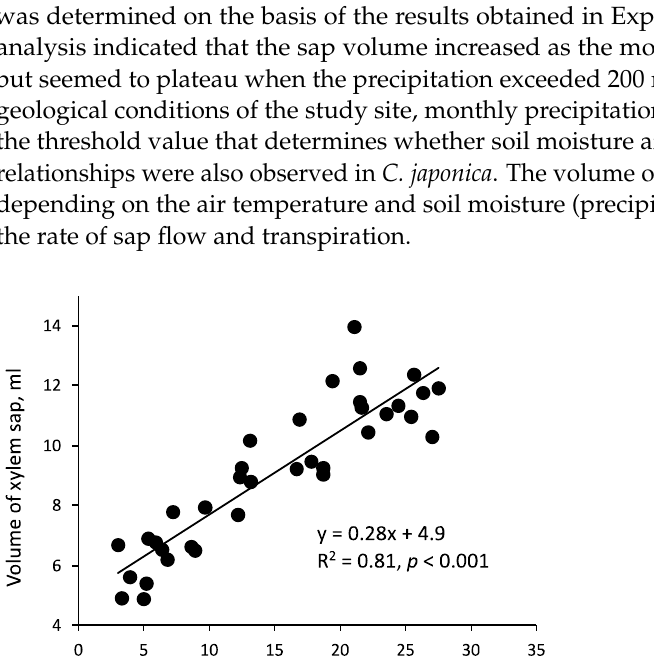
Figure 4. Relationship between the monthly volume of xylem sap collected in Q. serrata and the monthly precipitation. The presented data were from Experiments 1–3. The above results suggested that the volume of xylem sap collected was associated with the sap flow. Although the volume of sap collected was considerably smaller than that expected from the actual sap flow rates in trunks ( Q. serrata : 85–518 mL/cm 2 /d [82]; C. japonica : 27–69 mL/cm 2 /d [54]), probably because of the discontinuity of sap flow in the sampling holes [83], the changes in the volume of sap collected appeared to have syn- chronized with those in the sap flow rates. Additionally, even when only a few conduits or tracheids were disconnected, the sap flow system remained functional because xylem sap can flow upward by bypassing damaged areas [84]. Xylem sap can flow slowly in a radial direction through the pits of conduits or tracheids and/or the xylem ray paren- chyma [85–91]. Therefore, the xylem sap collected was considered as the exudate from the healthy sap flow system. Moreover, the original solute concentrations and composi- tions may have been maintained. The acid fuchsin dye, which was injected into the xylem as a 0.1% solution (1000 mL) at ca. 50 cm below the sampling hole, was detected in the resin placed in the sampling hole. This may support the collection of the intact xylem sap. Notably, the collected sap was the exudate when the continuous sap flow was disrupted. Precipitation, mm